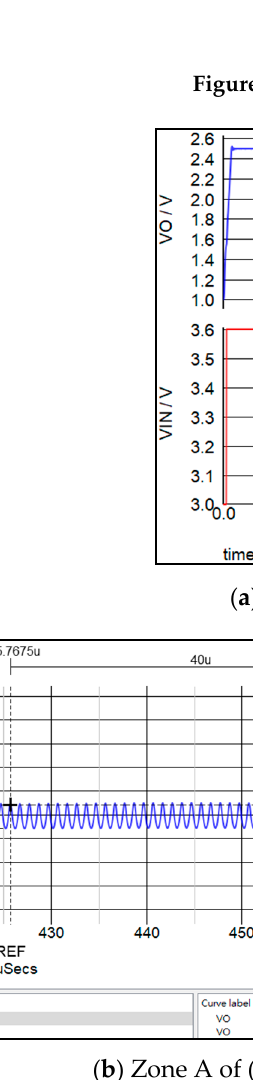
Figure 9. Recovery times for load current transition (100–500 mA).